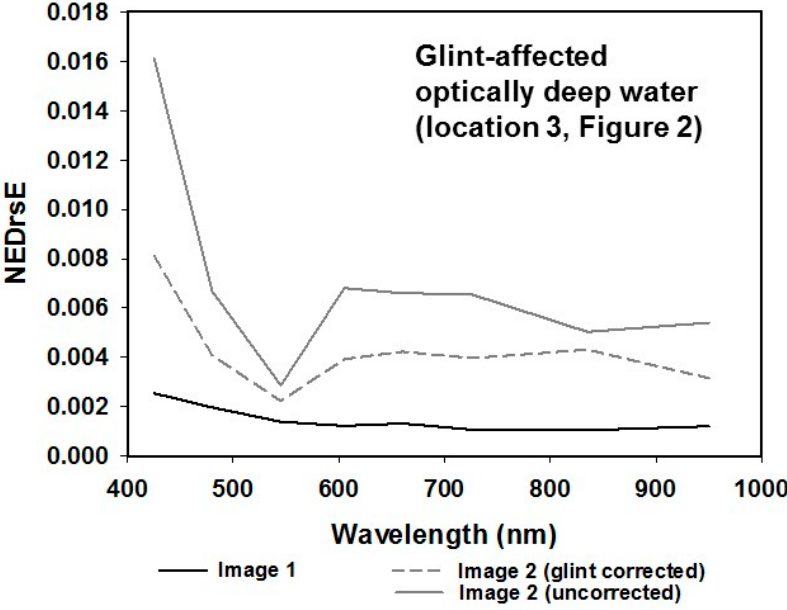
Figure 4. NE Δ rsE, a standard deviation computed on a kernel of 35 × 35 pixels collected over an as homogenous as possible area of optically deep water, from Image 1 and Image 2, illustrating the effects of environmental factors due to sunglint and related sun-sensor target geometry on the inherent noise of each individual image.